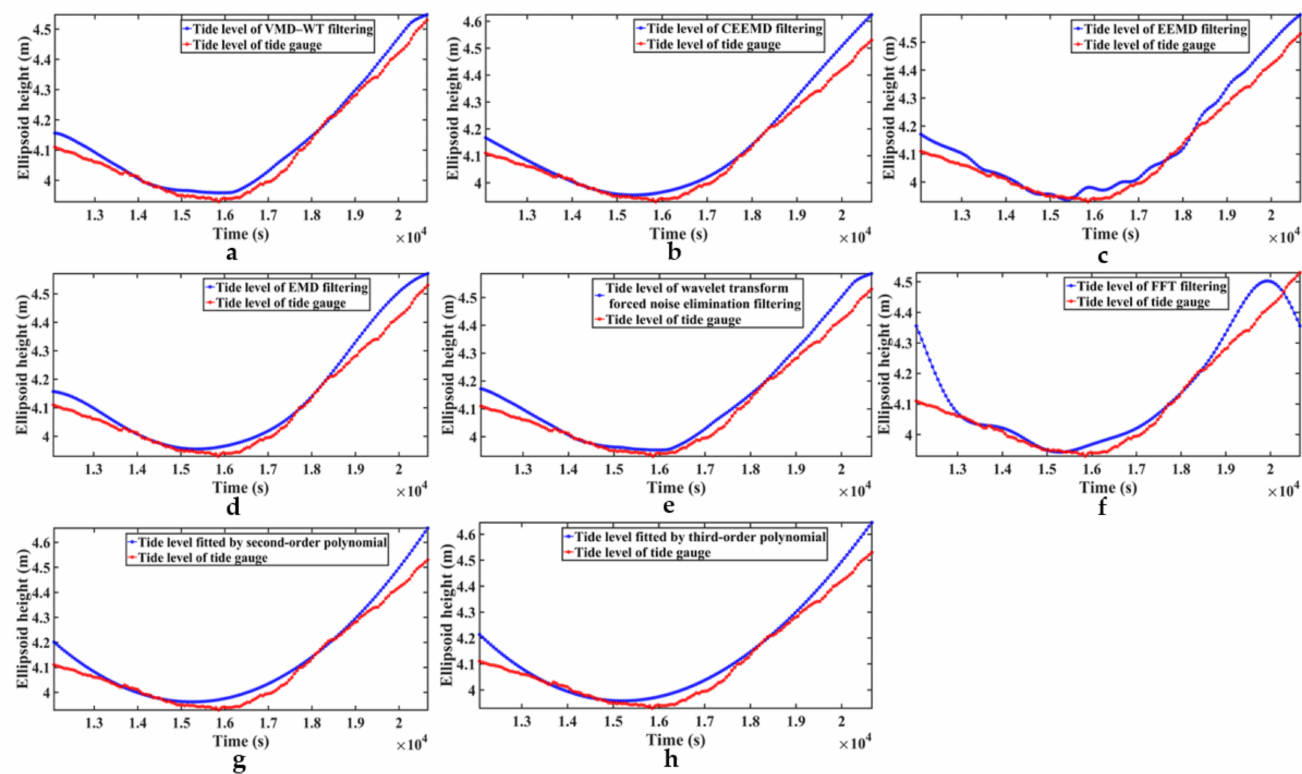
Figure 17. Comparison between the tide level of geodetic height extracted by eight filtering methods and the tide level of tide gauge for 2.4 h. ( a ) Tide level of VMD–WT filtering and the tide gauge; ( b ) Tide level of CEEMD filtering and the tide gauge; ( c ) Tide level of EEMD filtering and the tide gauge; ( d ) Tide level of EMD filtering and the tide gauge; ( e ) Tide level of wavelet transform forced noise elimination filtering and the tide gauge; ( f ) Tide level of FFT filtering and the tide gauge; ( g ) Tide level of second-order polynomial fit and the tide gauge; ( h ) Tide level of third-order polynomial fit and the tide gauge.